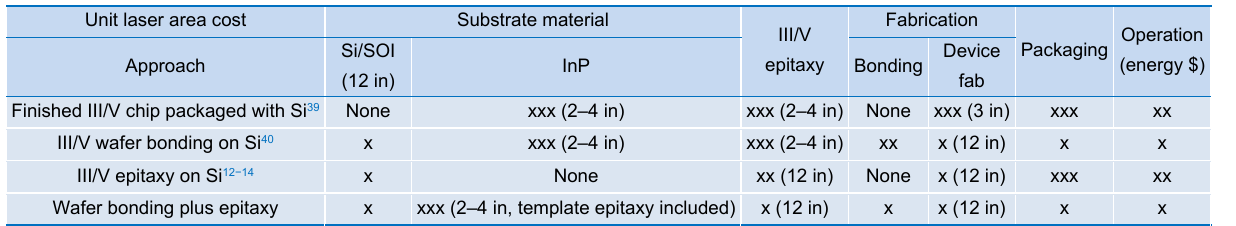
Table 2 | Qualitative comparison of production and operation costs of the same diode laser built on different III/V-on-silicon integration